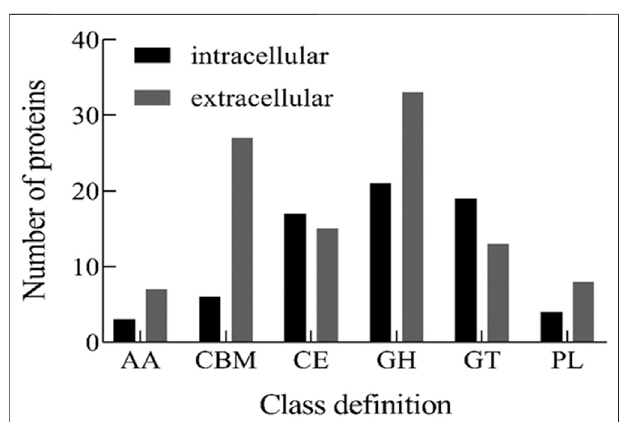
FIGURE 4 | CAZy classi fi cation of intracellular and extracellular proteins from Microbulbifer sp. ALW1 cultured with alginate. AA means auxiliary activity. CBM means carbohydrate-binding module. CE means carbohydrate esterase. GH means glycoside hydrolases. GT means glycosyltransferases. PL means polysaccharide